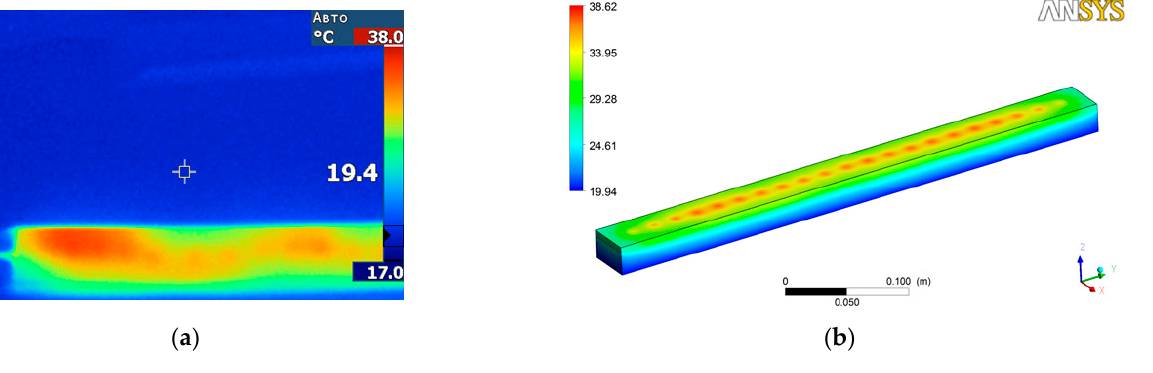
Figure 4. Calculated and simulated temperature distribution over the surface of the plastic housing of a linear LED luminaire: ( a ) thermal imaging; ( b ) calculated values as a result of modeling.